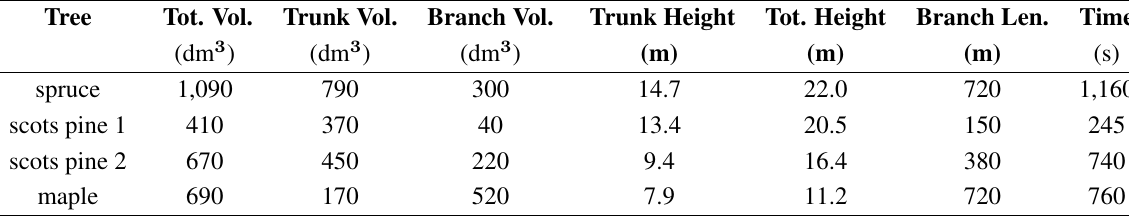
Table 3. Tree measures computed from the cylinder models. The time column gives the time for model completion (MacBook Pro, 2.8 GHz, 8 GB). The cover parameters were d = 2 . 0 cm and r = 2 . 5